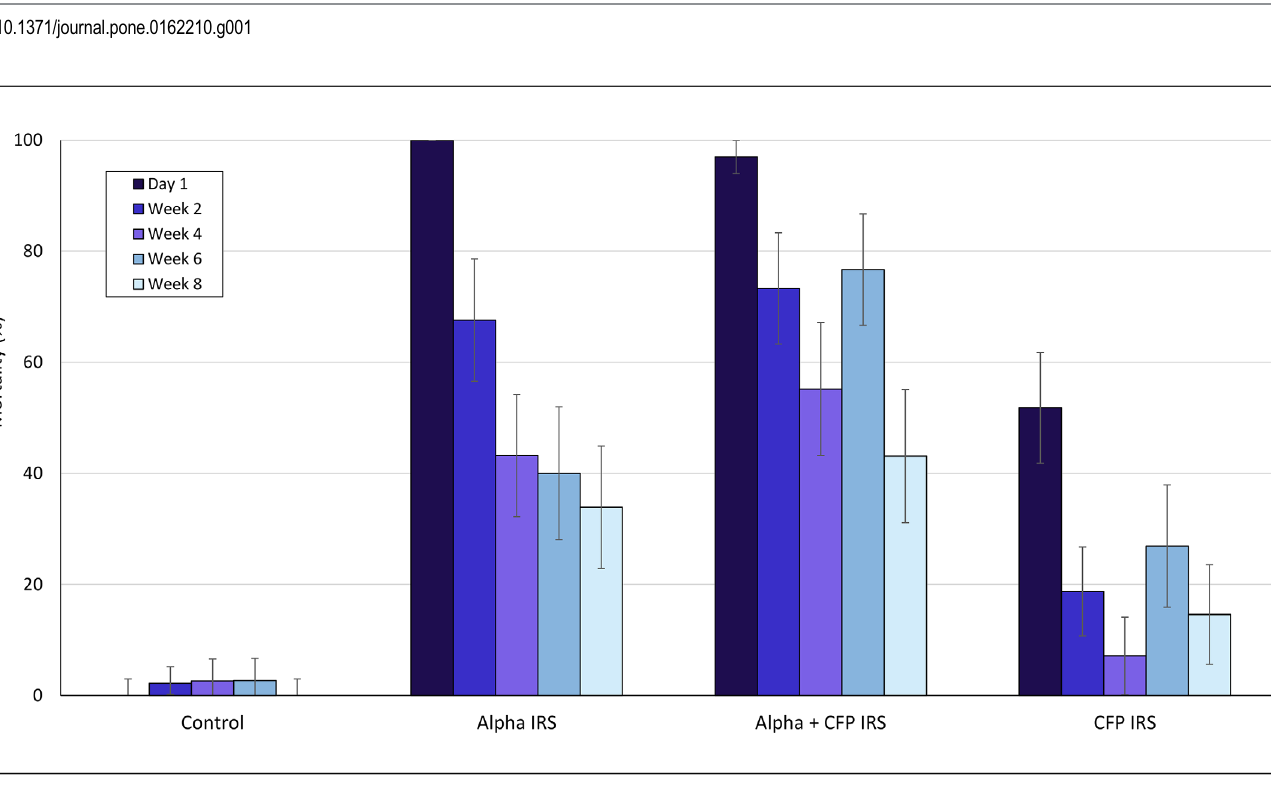
Fig 2. Mortality (%) of susceptible An gambiae Kisumu in fortnightly in situ cone bioassays in IRS treated experimental huts in Cove. Error bars represent 95% CI. alpha = alpha-cypermethrin, CFP = chlorfenapyr. doi:10.1371/journal.pone.0162210.g002 PLOS ONE | DOI:10.1371/journal.pone.0162210 September 2,